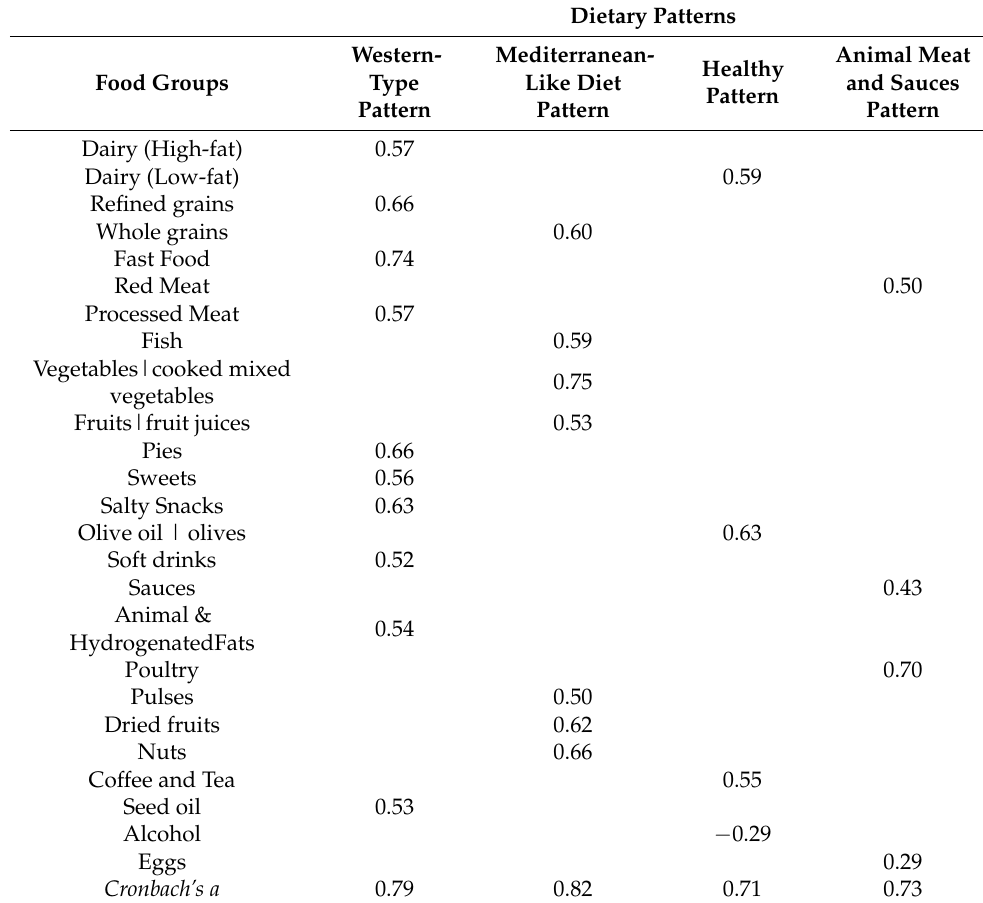
Table 2. Food groups and respective factor loadings for the four dietary patterns of the study.